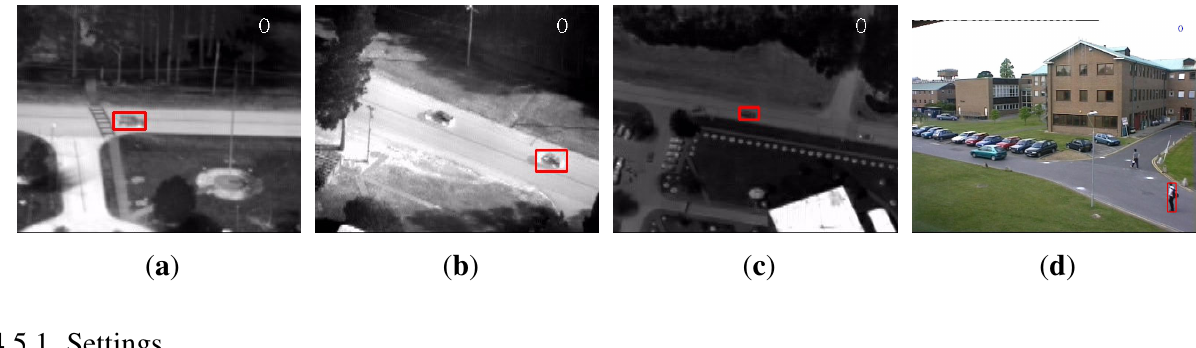
Figure 1. Initial frame of each sequence with target marked in rectangle. ( a )